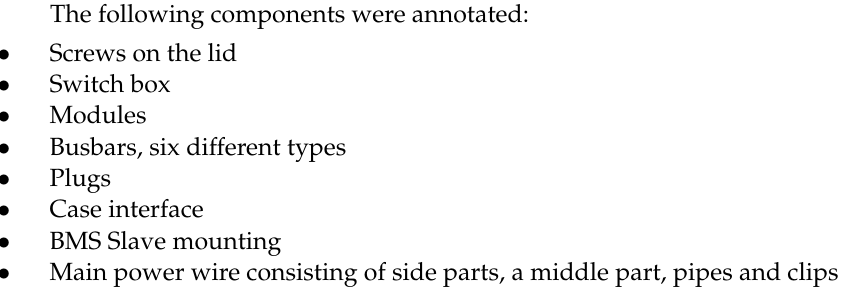
Figure 9. Annotation for instance segmentation with Labelme with the example of the